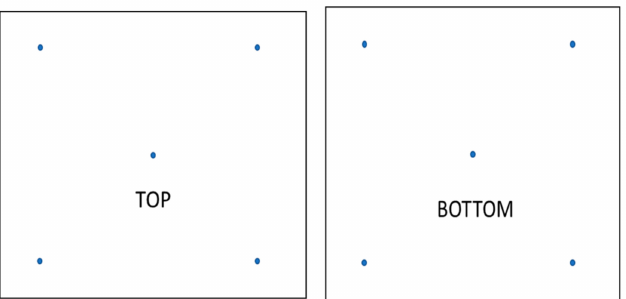
Figure 2. Scheme of selected points (blue dots) for ATR-FTIR analysis for evaluating coating